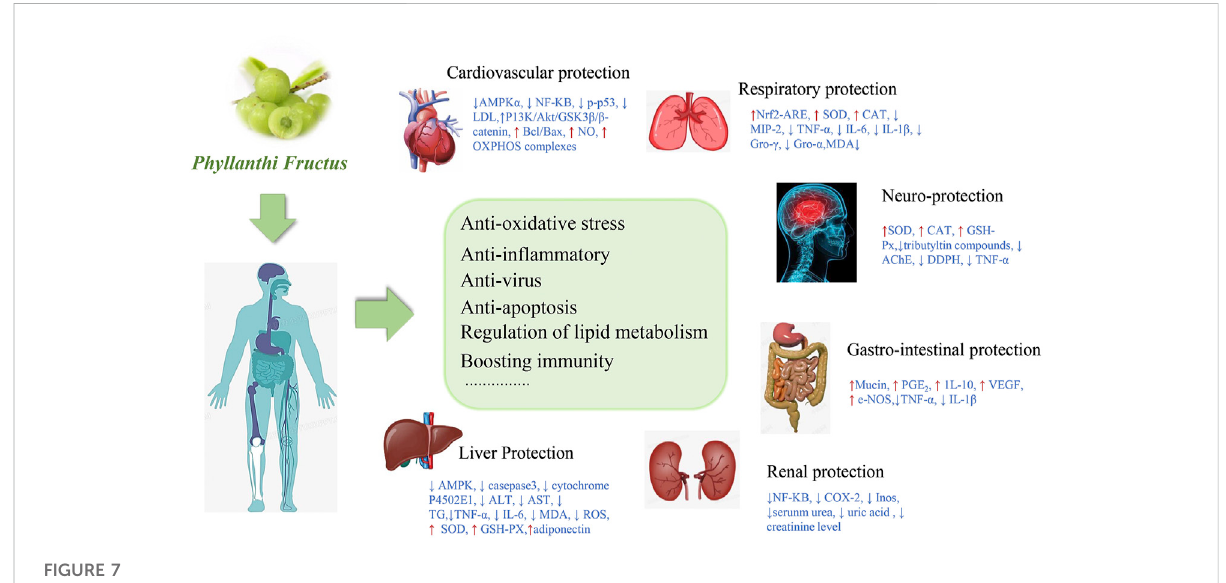
FIGURE 7 The pharmacological effects of PF on the body.